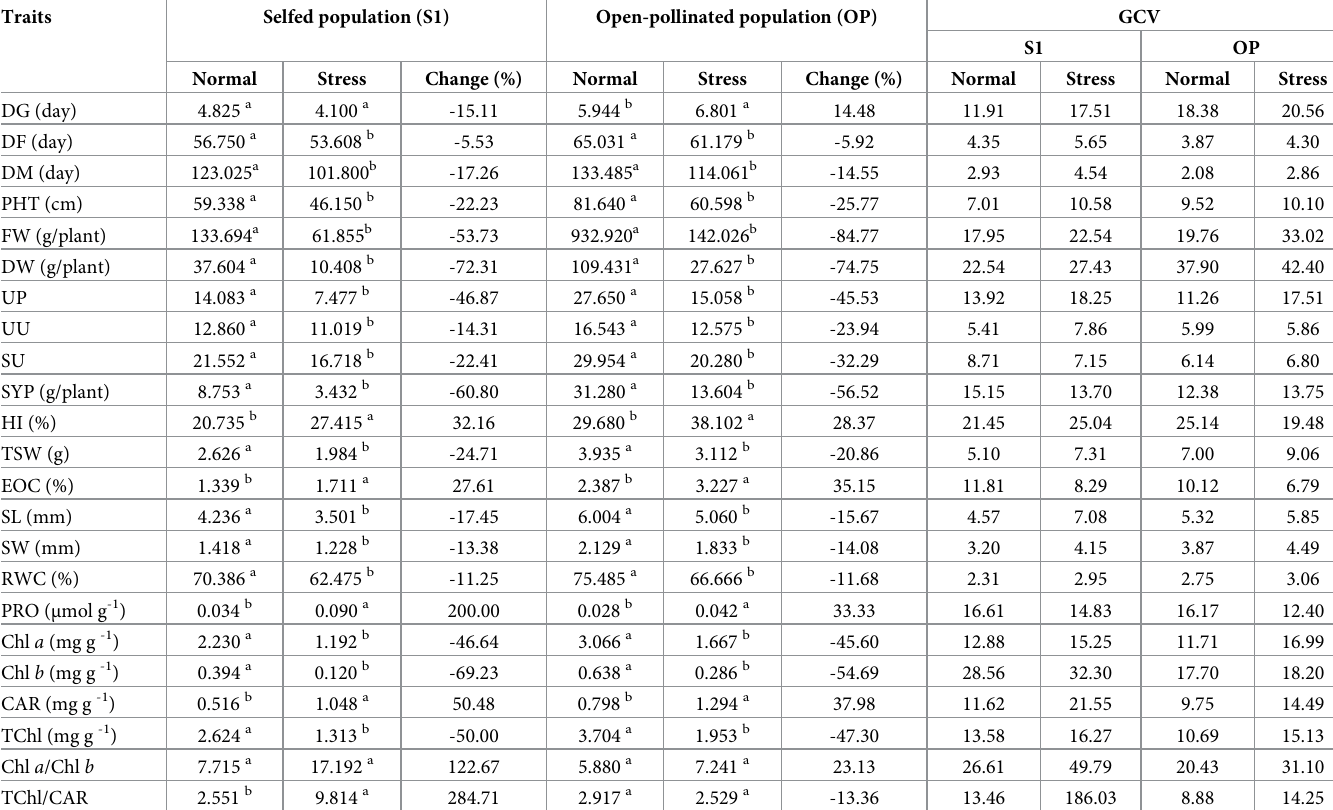
Table 2. The effect of water deficit, range, and genotypic coefficient of variation (GCV) of different traits recorded under normal and water deficit conditions in fennel genotypes during two years (2019–2020).